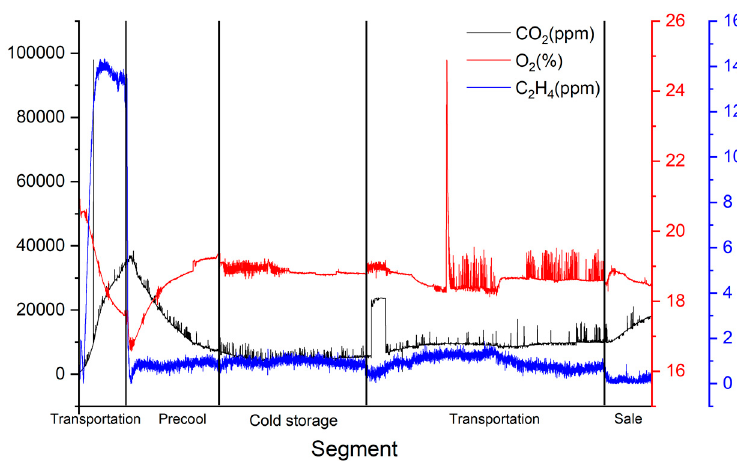
Figure 6. The change of gas concentrations in the fragrant pear cold chain.